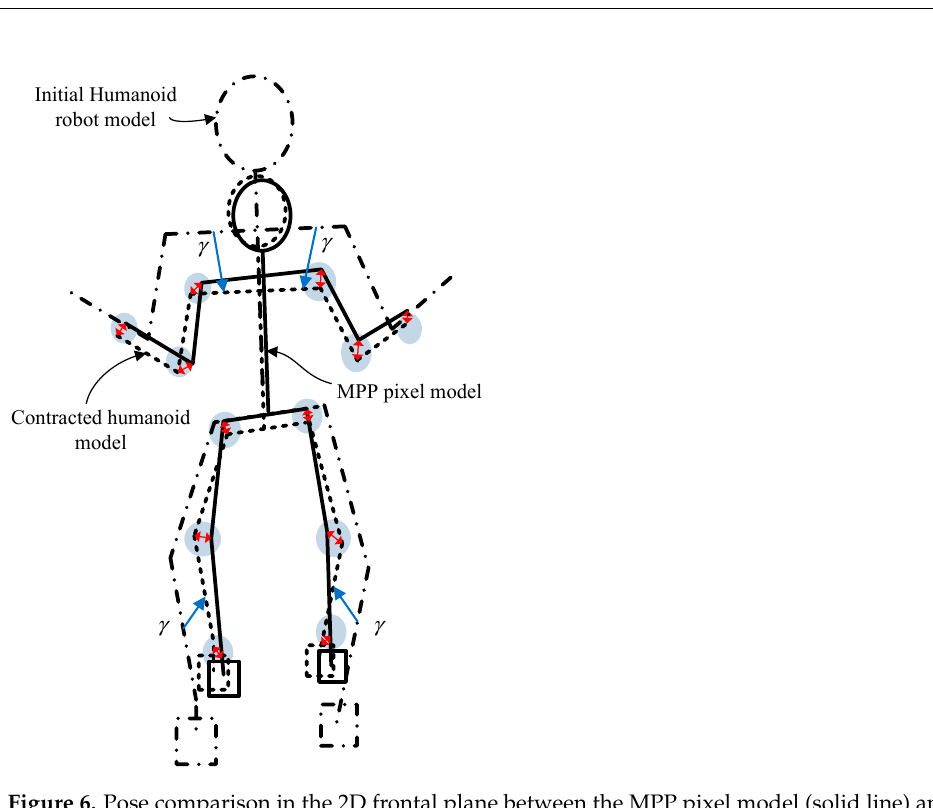
Figure 6. Pose comparison in the 2D frontal plane between the MPP pixel model (solid line) and the fitted model (dashed line) contracted from the initial humanoid model (dash-dotted line).